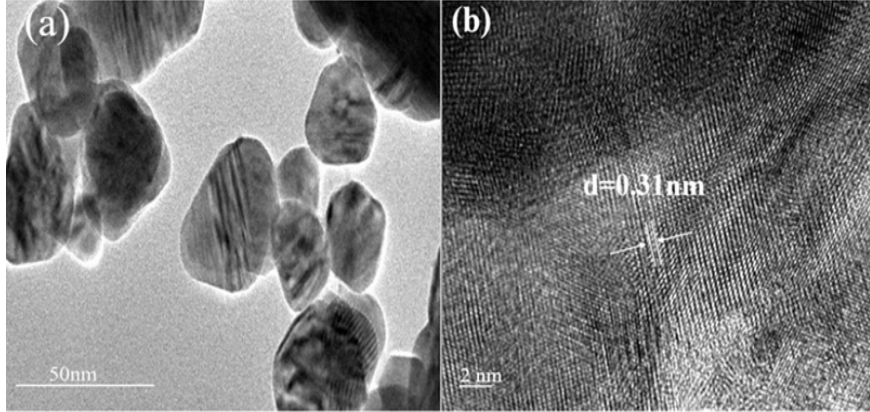
Figure 2. ( a ) TEM and ( b ) HRTEM images of the 0.3ZCS sample.